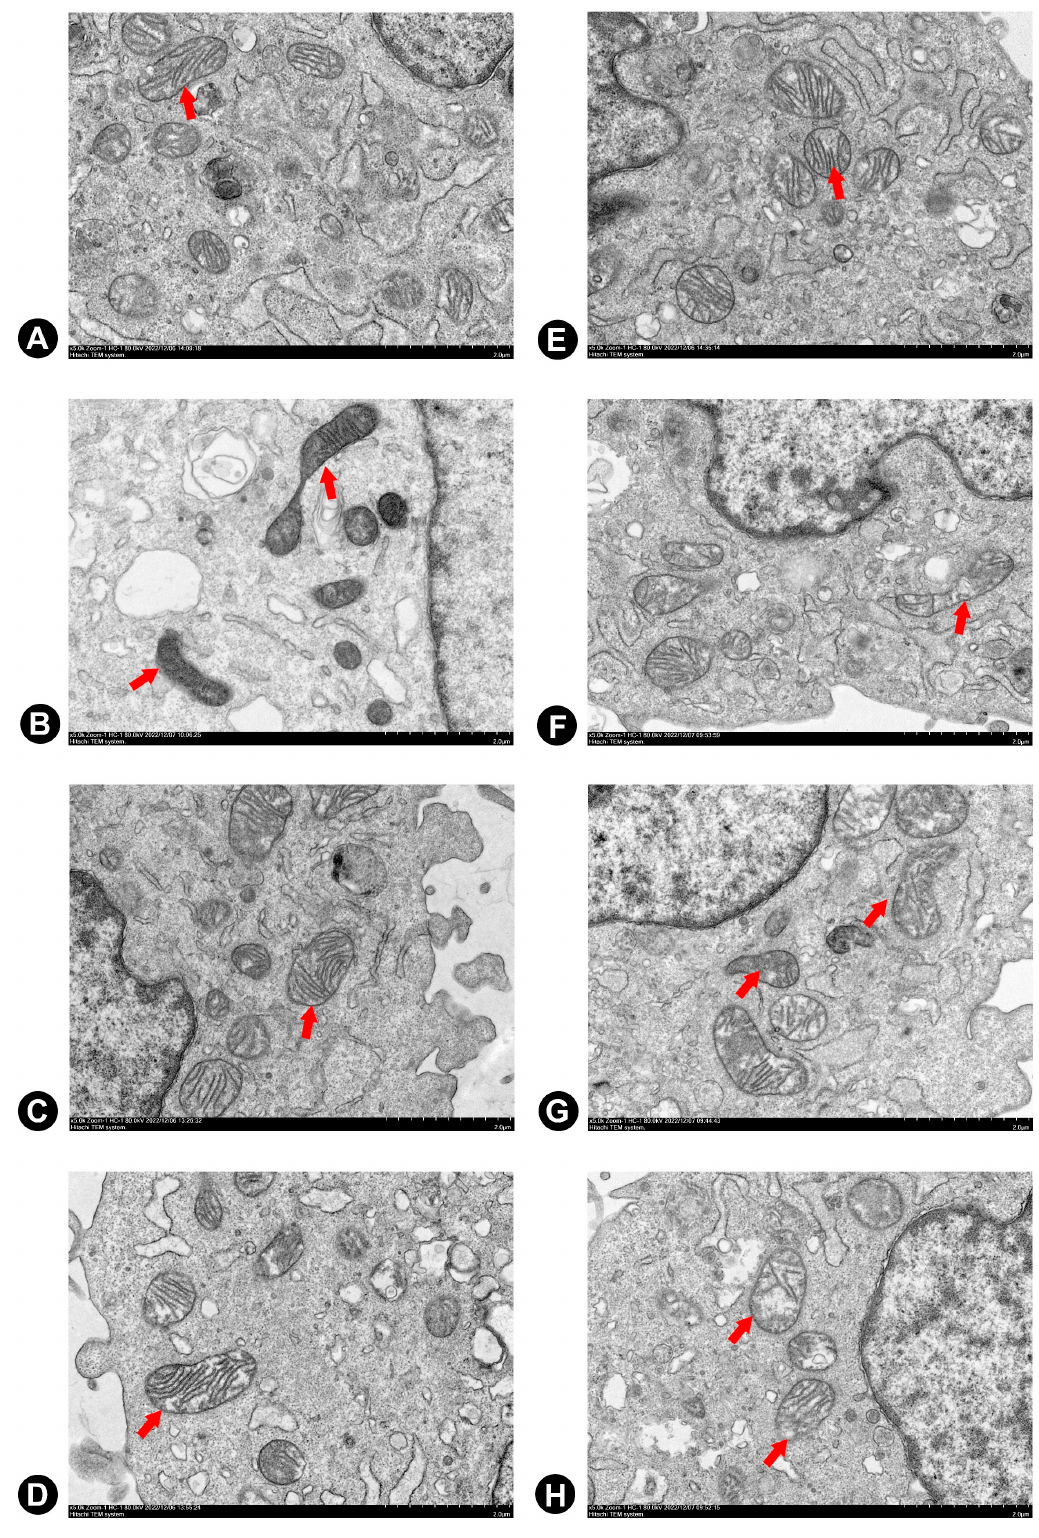
Figure 7. The effects of three flavonoids on mitochondrial ultrastructure during Dox-induced cardiotoxicity by SEM (5000×). Cells were pretreated with same concentrations of F-A, F-B, and F-C (10 μ M) for 1 h, then exposed to Dox for 24 h. ( A ) NC Group; ( B ) 2.5 μ M Dox Group; ( C ) F-A Group; ( D ) F-B Group; ( E ) F-C Group; ( F ) F-A + 2.5 μ M Dox Group; ( G ) F-B + 2.5 μ M Dox Group; and ( H ) F-B + 2.5 μ M Dox Group.